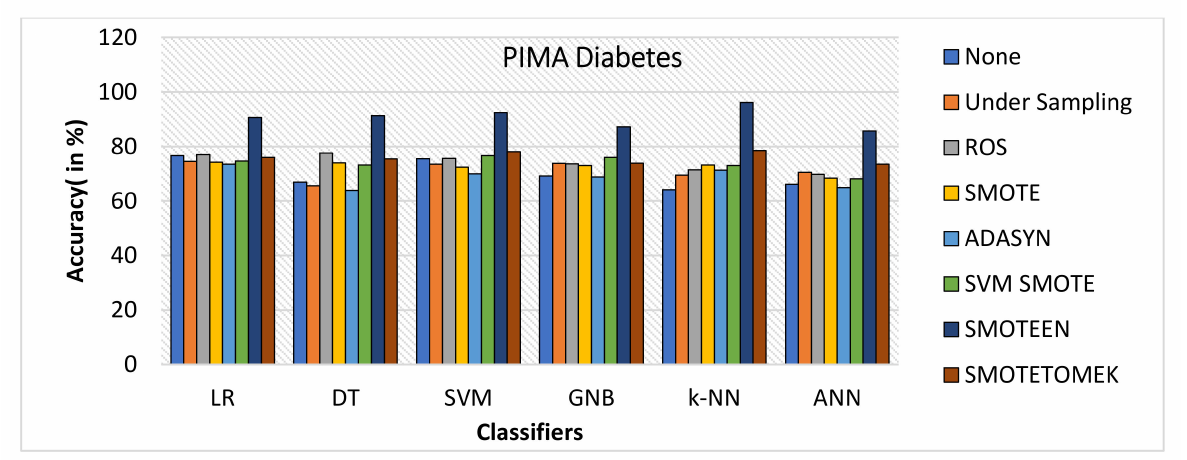
Figure 22. Accuracy for diabetes dataset of balancing algorithms over six classifiers.